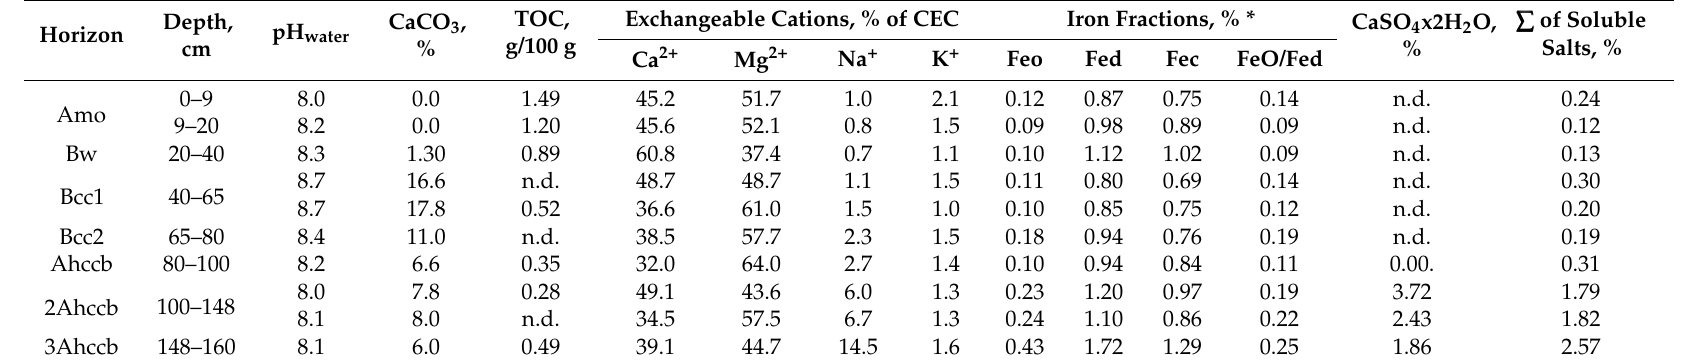
Table 2. Selected chemical features of the pedocomplex.